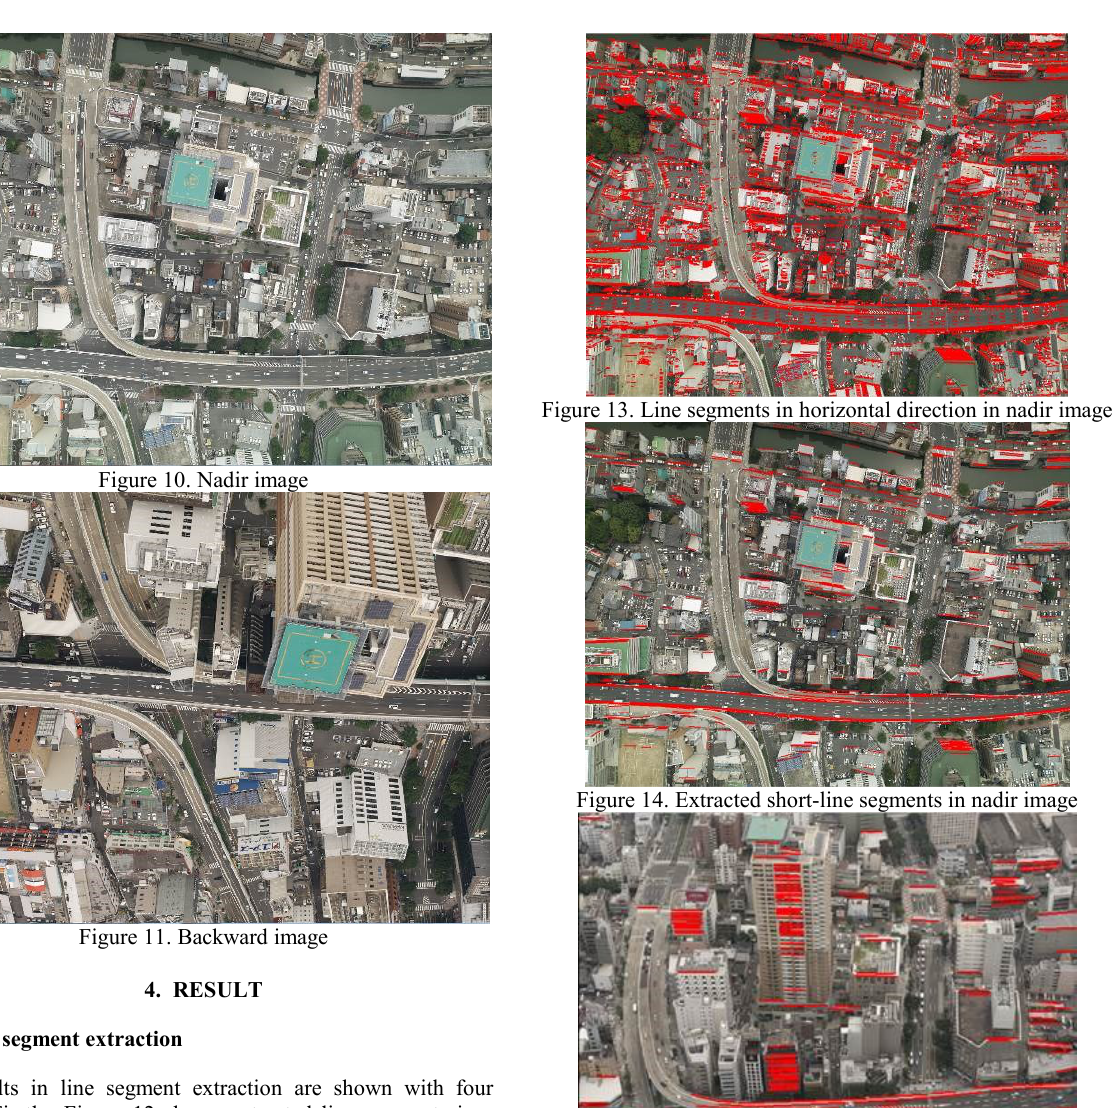
Figure 14. Extracted short-line segments in nadir image